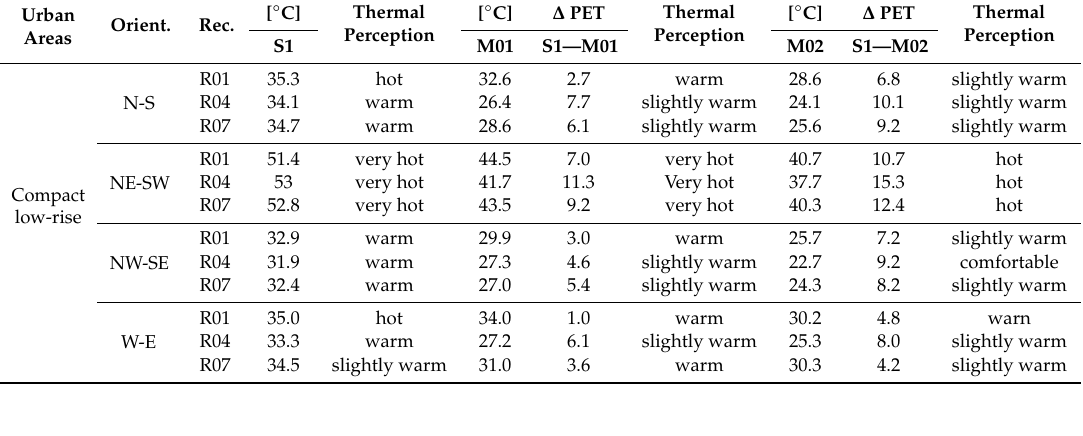
Table 14. PET peak values, for R01, R04 and R07 in compact lo-rise urban areas for the scenario with red brick stones, M01 (pavement in red brick stone and constant ratio Ht / H = 0.25) and M02 (pavement in brick red stone and constant ratio Ht / H = 0.25 and Wt / W = 0.30).